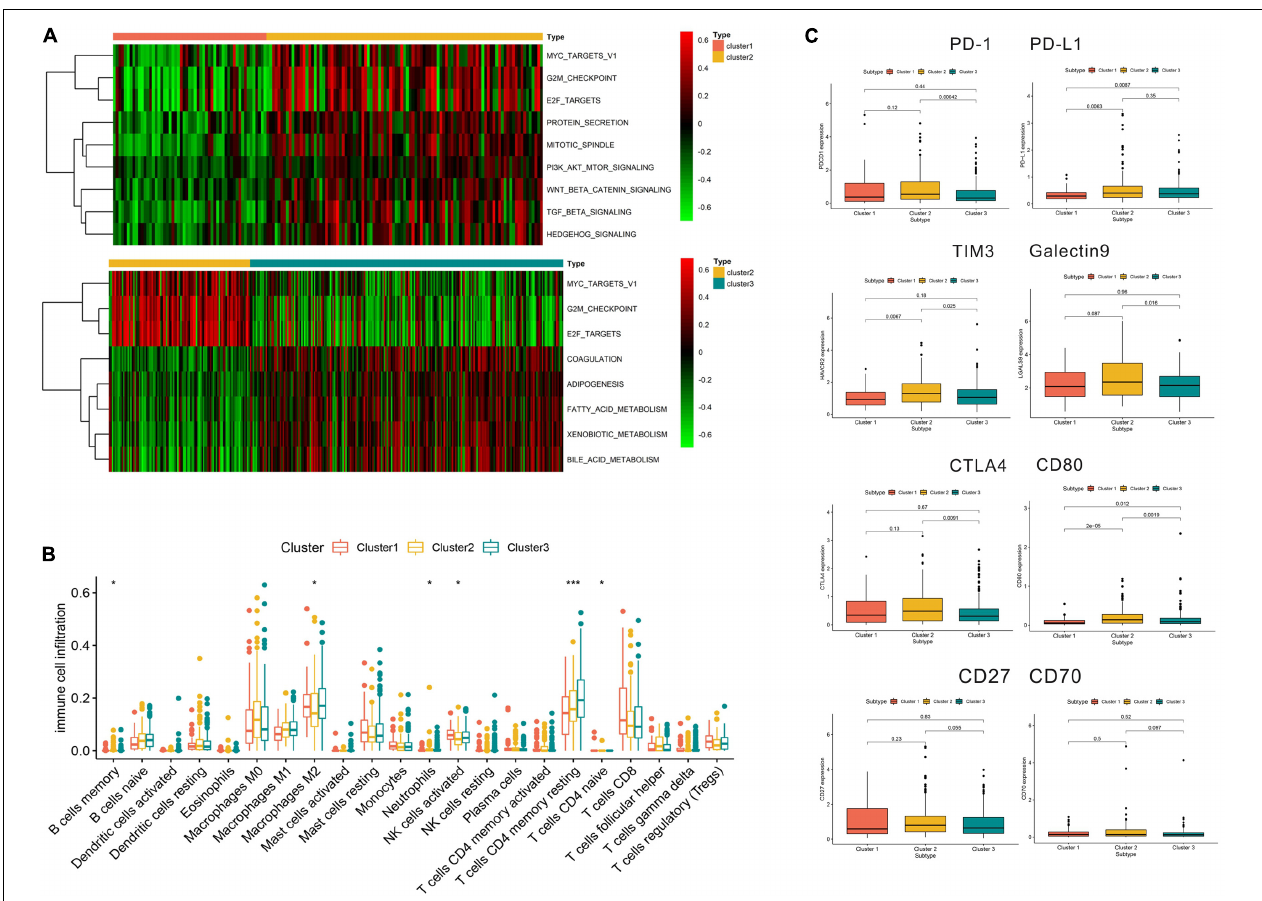
FIGURE 5 | Relevant signaling pathways, immune cell infiltration, and immune checkpoints in subtypes. Panel (A) shows the results of gene set variation analysis. (B) Immune cell infiltration in the three subtypes. (C) Correlation between immune checkpoints and subtypes. In panel (B) , * p < 0.05, ** p < 0.01, *** p <